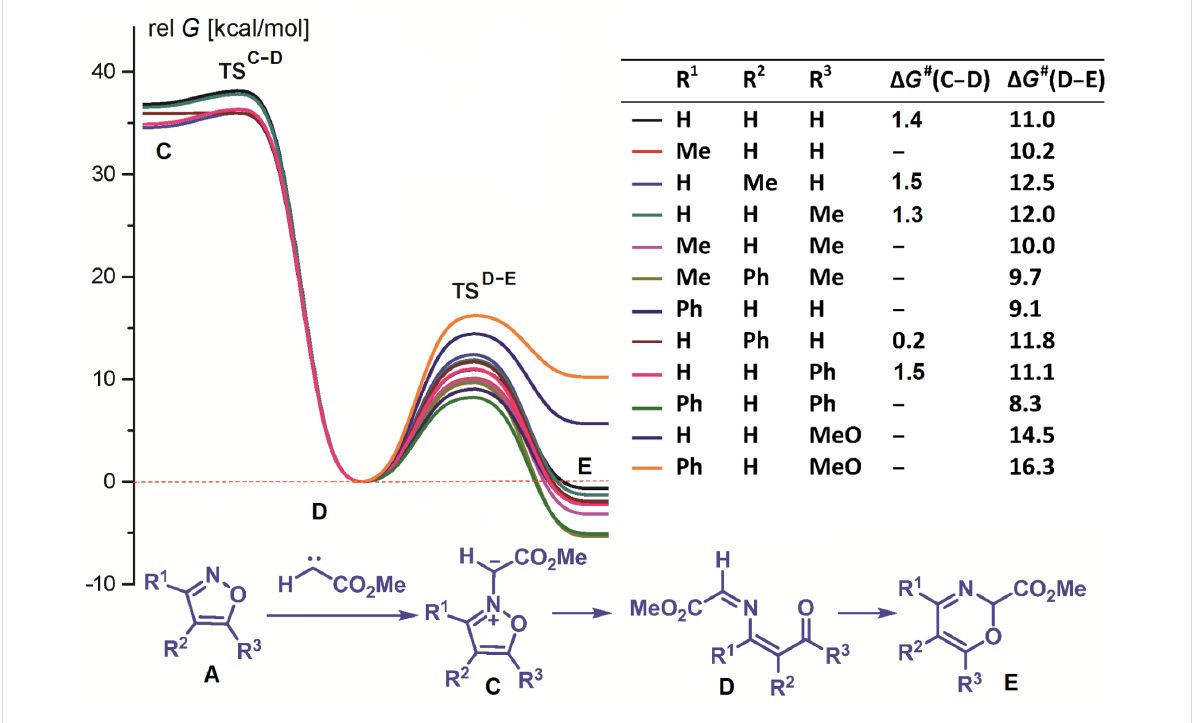
Figure 1: Energy profiles for the transformations of ylides C , (3 Z )-1-oxa-5-azahexa-1,3,5-triene D and oxazines E derived from methoxycarbonylcar- bene and isoxazole A . Relative free energies [kcal/mol, 298 K, CH 2 Cl 2 (PCM)] computed at DFT B3LYP/6-31G(d)